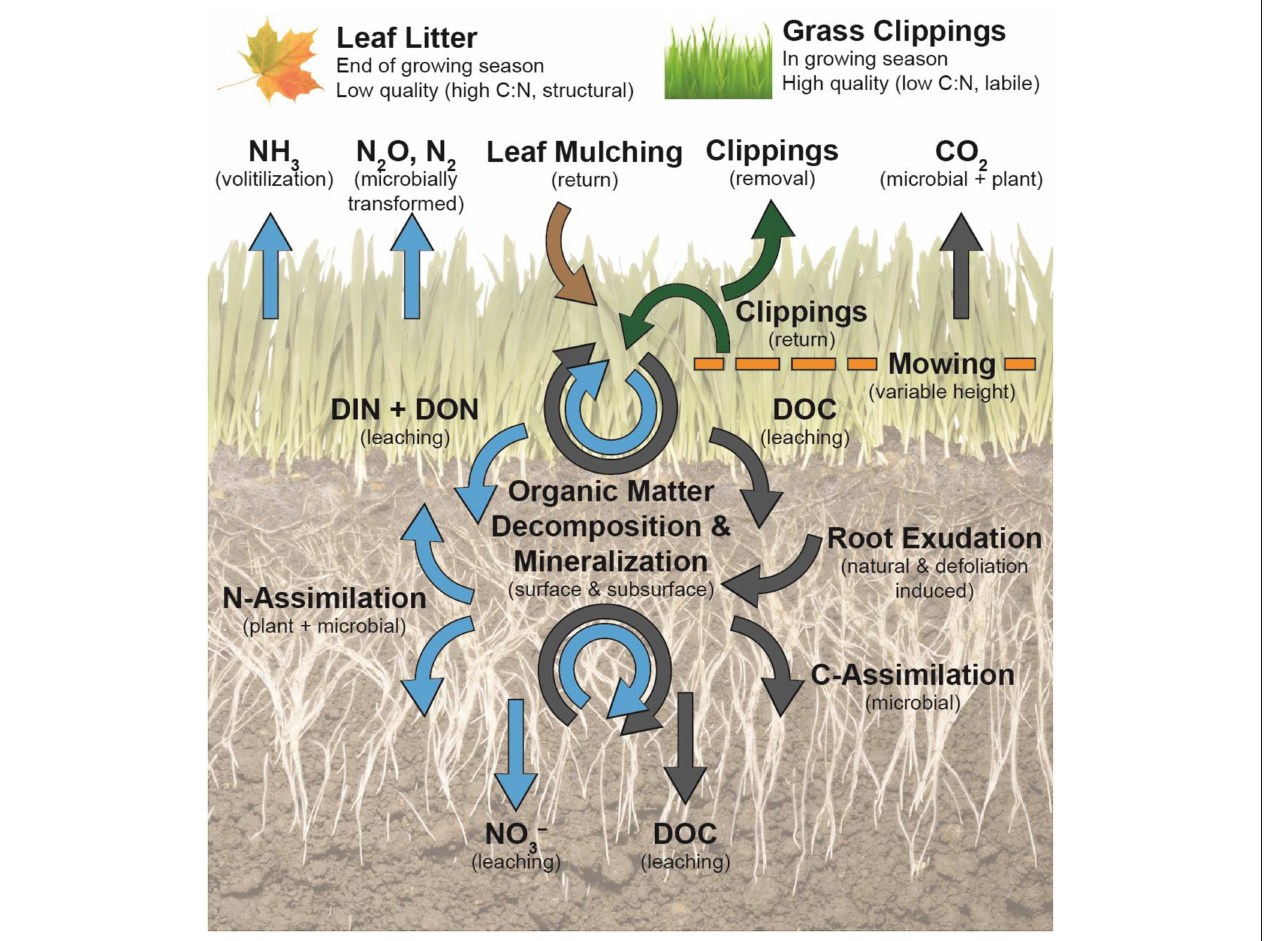
FIGURE 3 | Turfgrass litter management practices affect dominant C (gray arrows) and N (blue arrows) flows and soil organic matter dynamics at the soil surface and subsurface. Defoliation by mowing stimulates turfgrass root exudation, which supplies the soil microbiome with labile C and creates a microbial N-sink. Microbially mineralized N can be assimilated by microorganisms or turfgrass roots, leached, or lost via gaseous pathways. Grass clippings (green arrows) are more labile forms of litter in comparison to senesced urban tree leaves and will accelerate decomposition and mineralization at the soil surface and in the thatch layer, if returned. Leached labile C and N compounds from decomposing clippings at the soil surface can contribute to rhizosphere N demands. Removal of grass clippings take away C and N. Leaf litter mulching (brown arrow) is more recalcitrant, contains less N, and is more resistant to microbial degradation. The effect of leaf litter residue on soil C and N in lawns is less